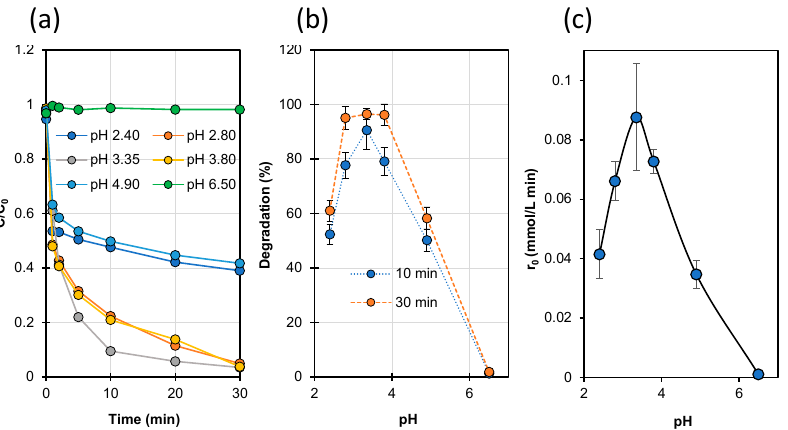
Figure 3. Effect of pH on the dynamics of STZ degradation ( a ), the degree of degradation after 10 and 30 min of reaction ( b ) and the initial degradation rate of STZ ( c ). [STZ] 0 = 0.1 mmol/L, [FeSO 4 ] 0 = 0.15 mmol/L, [H 2 O 2 ] 0 = 2.0 mmol/L, pH = 3.35 ± 0.05.